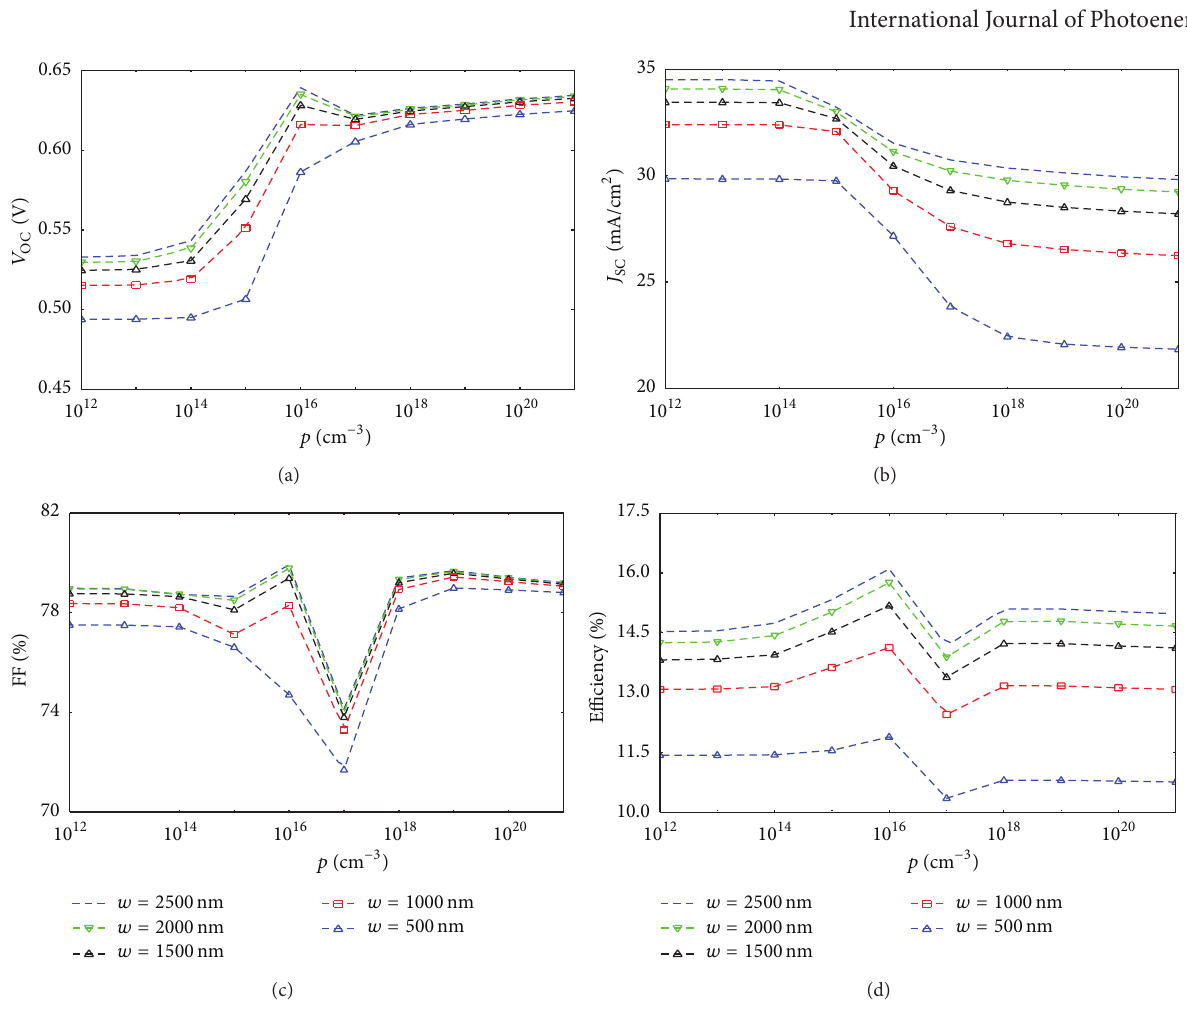
, 𝐽 , FF, and the efficiency as a function of the CIGS absorber thickness. oc sc